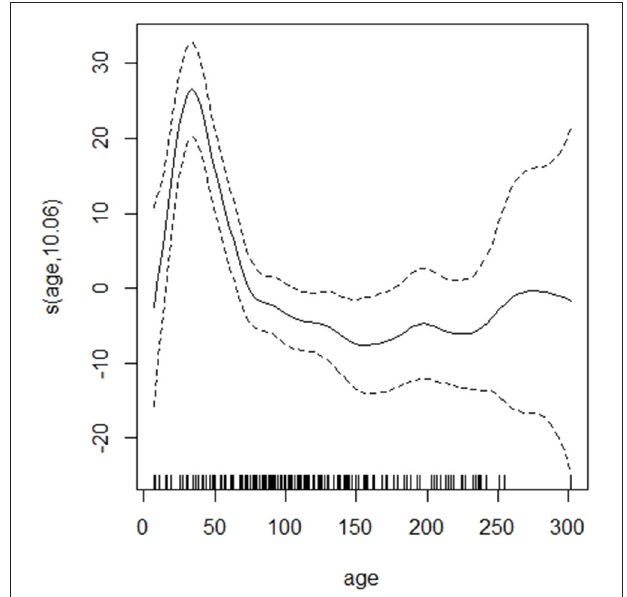
FIGURE 1 | The association between age (in days) and hair cortisol content of the dairy calves. Dotted lines indicate 95%